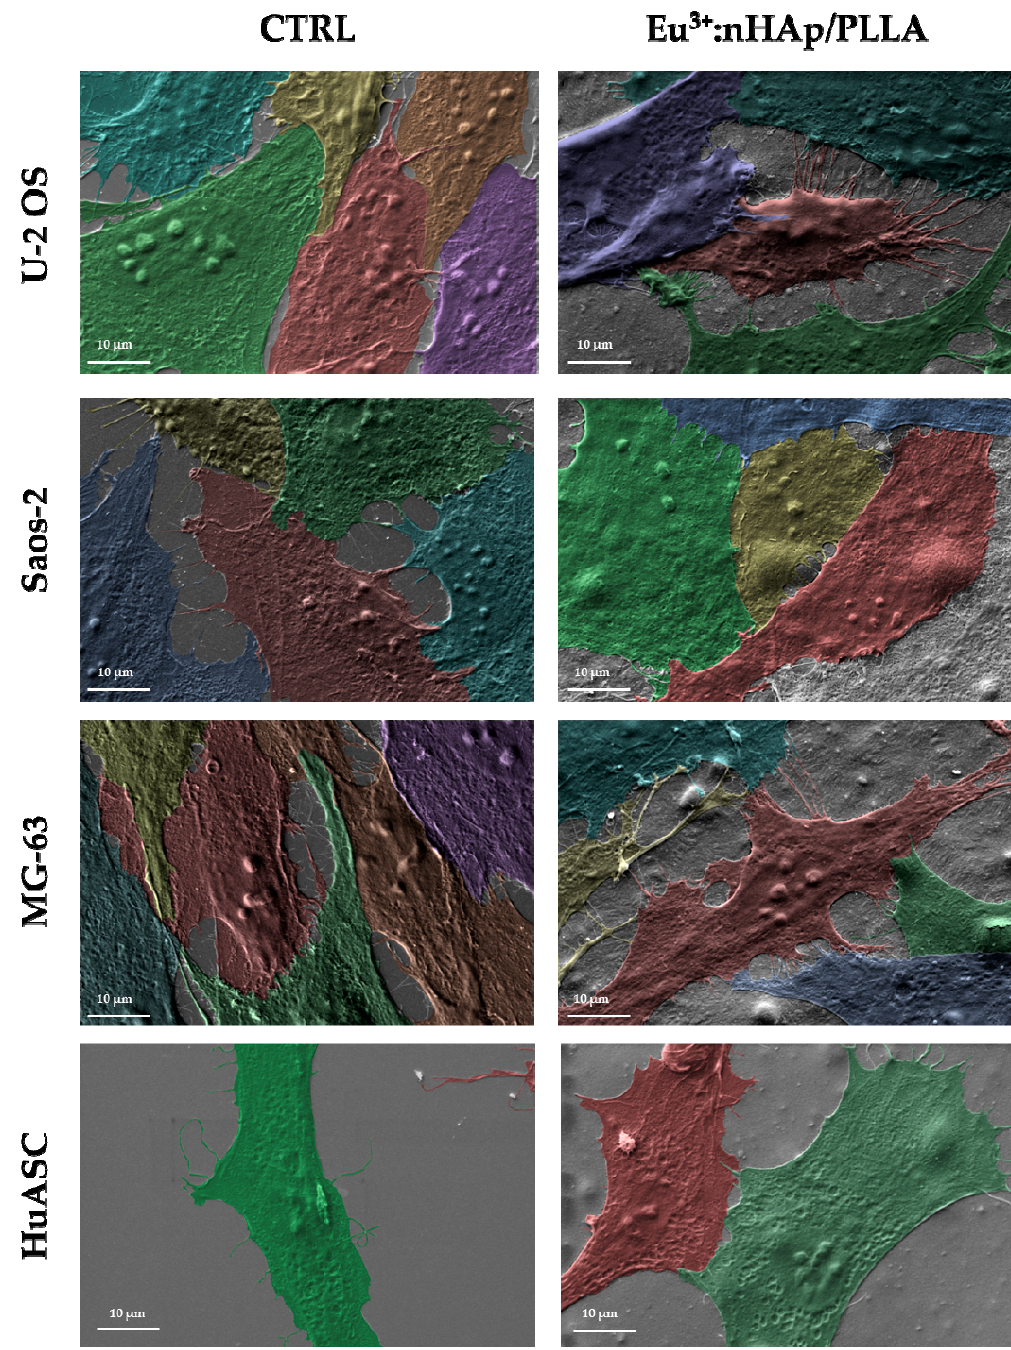
Figure 2. The adhesion and intercellular interactions of cells cultured on polystyrene (CTRL) and biomaterial (10 wt % 3 mol % Eu 3+ : nHAp/PLLA. The cells were visualized using electron microscope (SEM). Magnification: 4000×, scale bar: 10 µm.